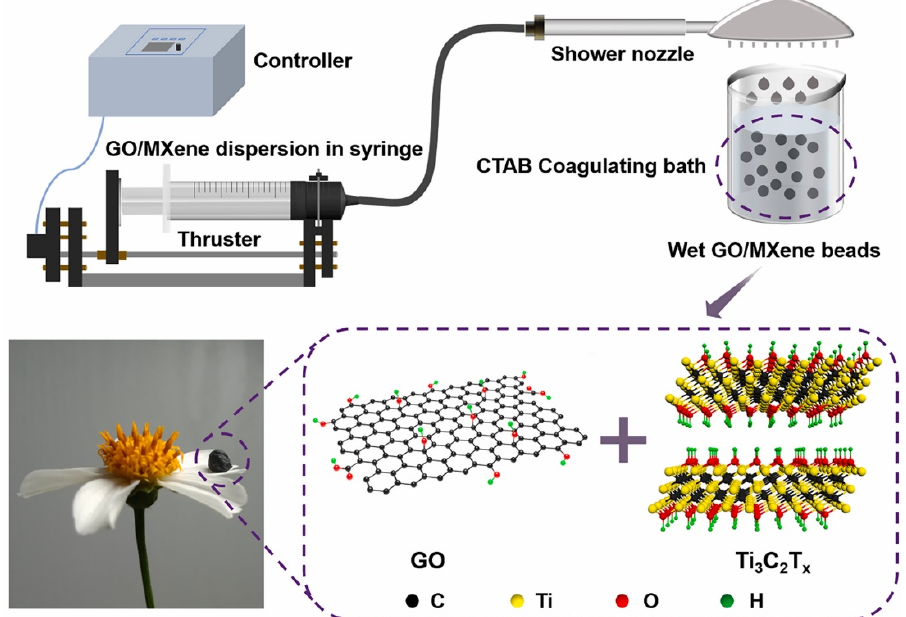
Figure 2. Schematic showing the hydrogen bond-induced self-assembling of beads for oil/water separation aerogel composite preparation. CTAB stands for the cetyltrimethylammonium bromide surfactant. Reproduced with permission from [40], ©2021 Elsevier B.V.